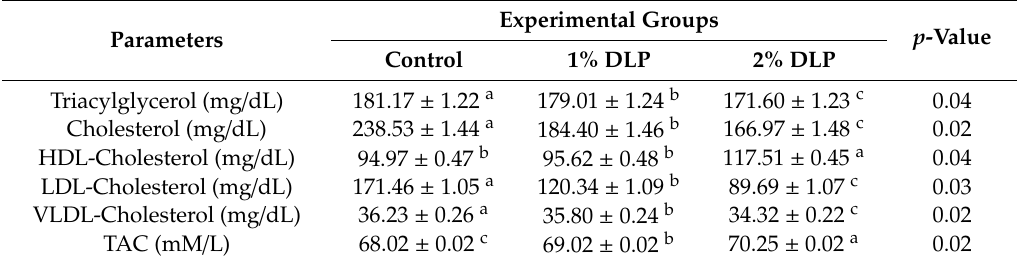
Table 6. Changes in serum levels of lipid profiles and total antioxidant capacity in rabbits treated with dietary dried lemon.